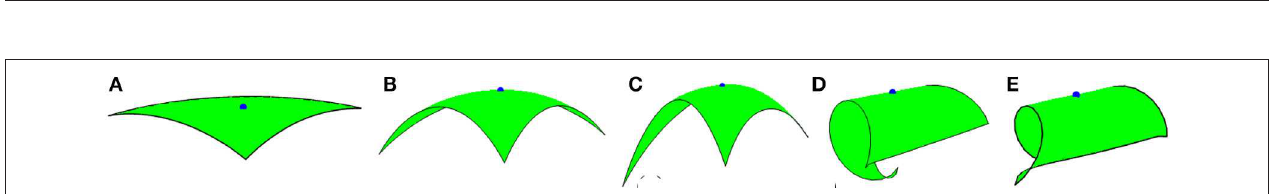
Frontiers in Materials |